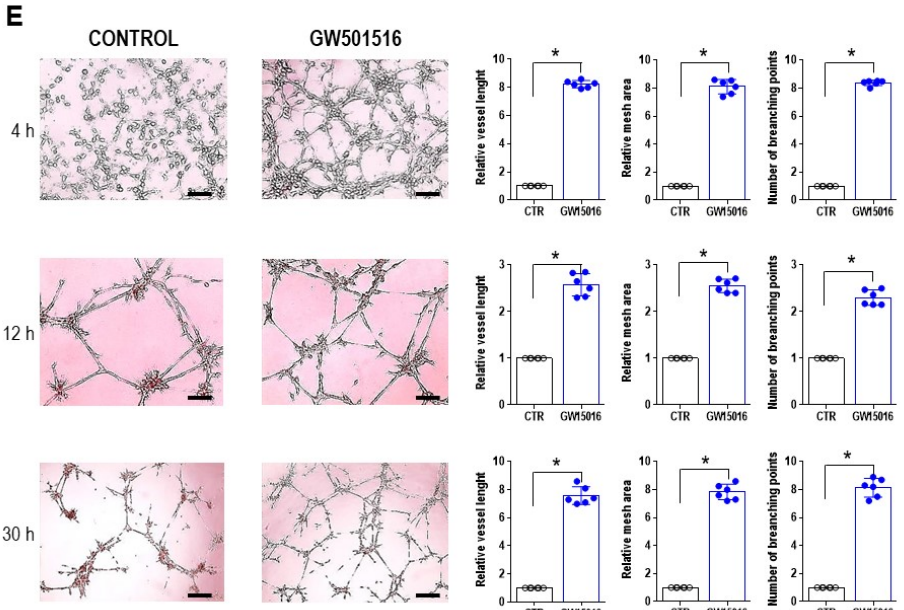
Figure 4. Stimulation of in vitro MMEC spreading, migration, and angiogenesis by a PPAR β / δ agonist. MMEC were cultured in serum-free medium alone (control) or in containing 10 nM GW501516 for different times. ( A , B ) Cell spreading assay. ( A ) Representative photomicrographs at 1 h; the cells were harvested, stained with crystal violet, and observed using an EVOS microscope. Round cells were considered unspread, and cells with a visible cytoplasm surrounding the nuclei and with membrane protrusions as spread. 200×; Scale bar, 50 µm. ( B ) Plot showing the percentage of spread cells. ( C , D ) Wound-healing assay. ( C ) Representative micrographs 12 h after confluent monolayers were scratched (dotted lines define the wound area). 200×; Scale bar, 50 µm. ( D ) Number of migrating cells in each wound of ( C ). ( E ) Matrigel angiogenesis assay. Representative micrographs at 4, 12, and 30 h of treatment revealing newly formed capillary networks on a Matrigel layer. The cell angiogenic behavior was evaluated by a topological analysis. 200×; Scale bar, 50 µm. Data are the mean ± SD of six independent experiments and were normalized to the control. * p < 0.05, ** p ≤ 0.01, Mann–Whitney test.